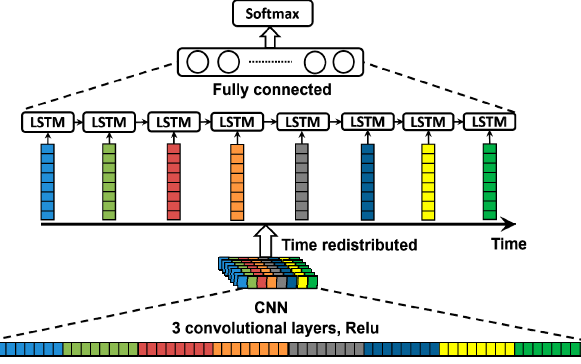
Figure 3. Architecture of the neural network for microseismic event detection. LSTM, long short-term memory; CNN, convolutional neural network.